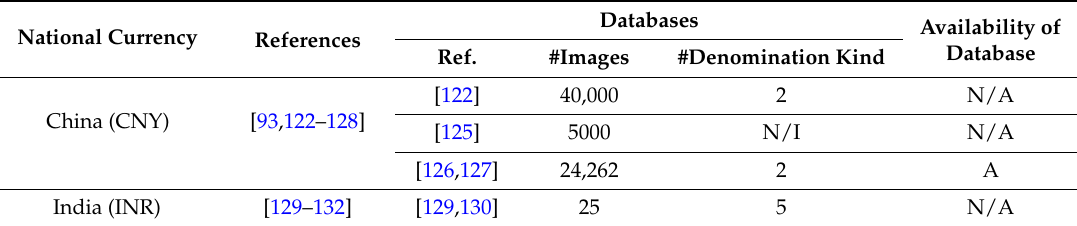
Table 10. Resources on serial number recognition by currency (Ref.: References, N/I: No Information, A: Available, N/A: Not Available).